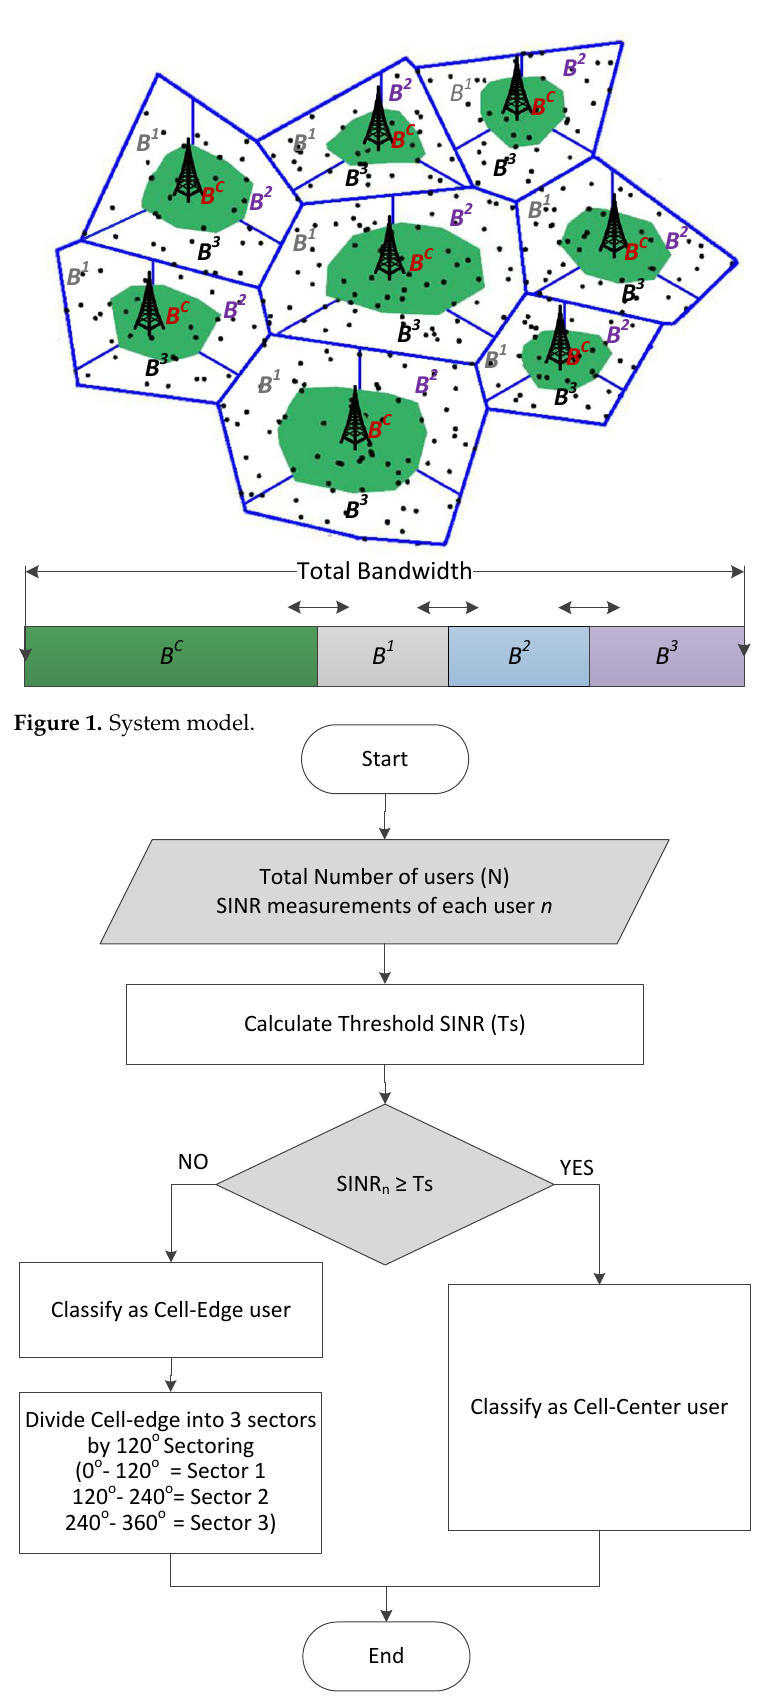
Figure 2. Flow-chart for cell partition and